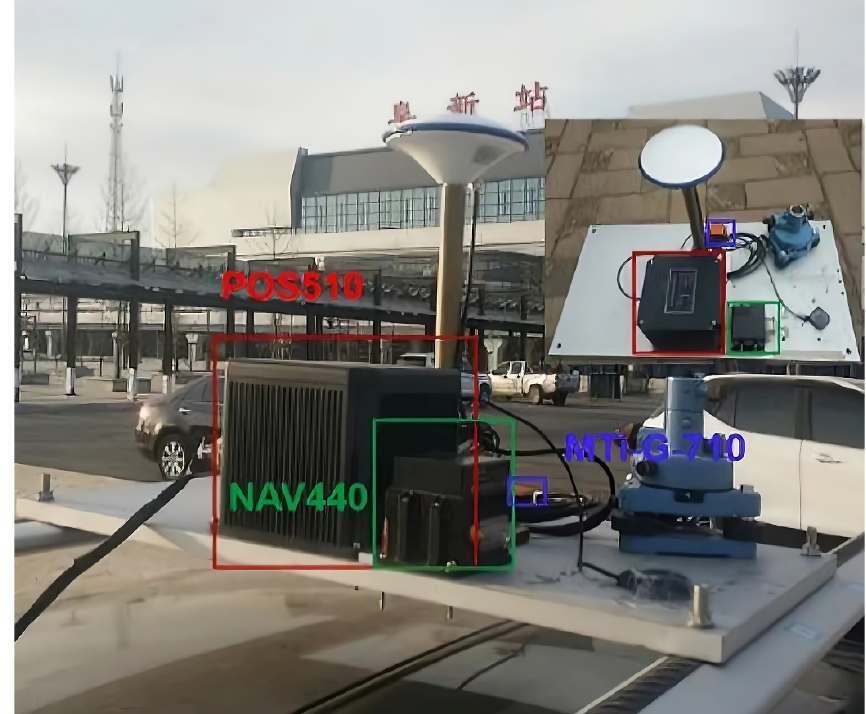
Figure 1. Construction of experimental environment.